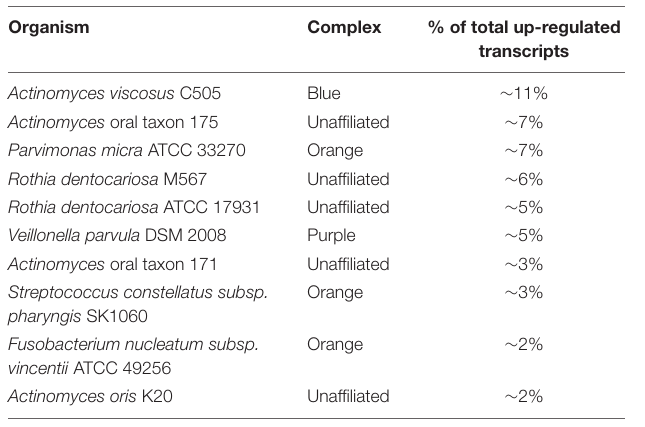
TABLE 1 | Species with the largest number of DE transcripts.